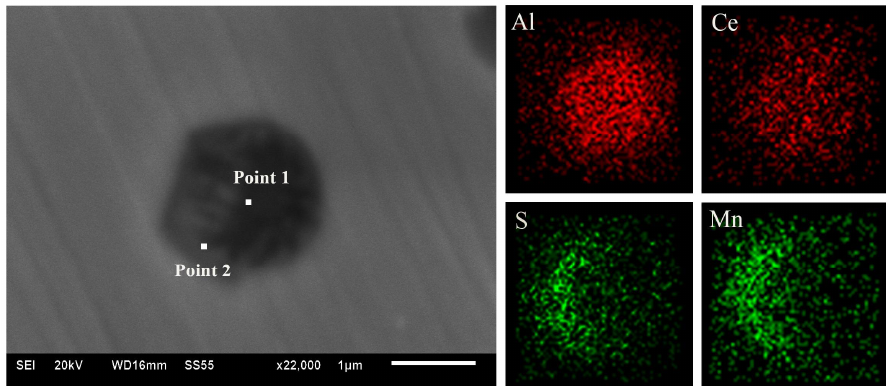
Figure 3. SEM micrograph and EDS mapping images of various elements for typical oxide in 3#.